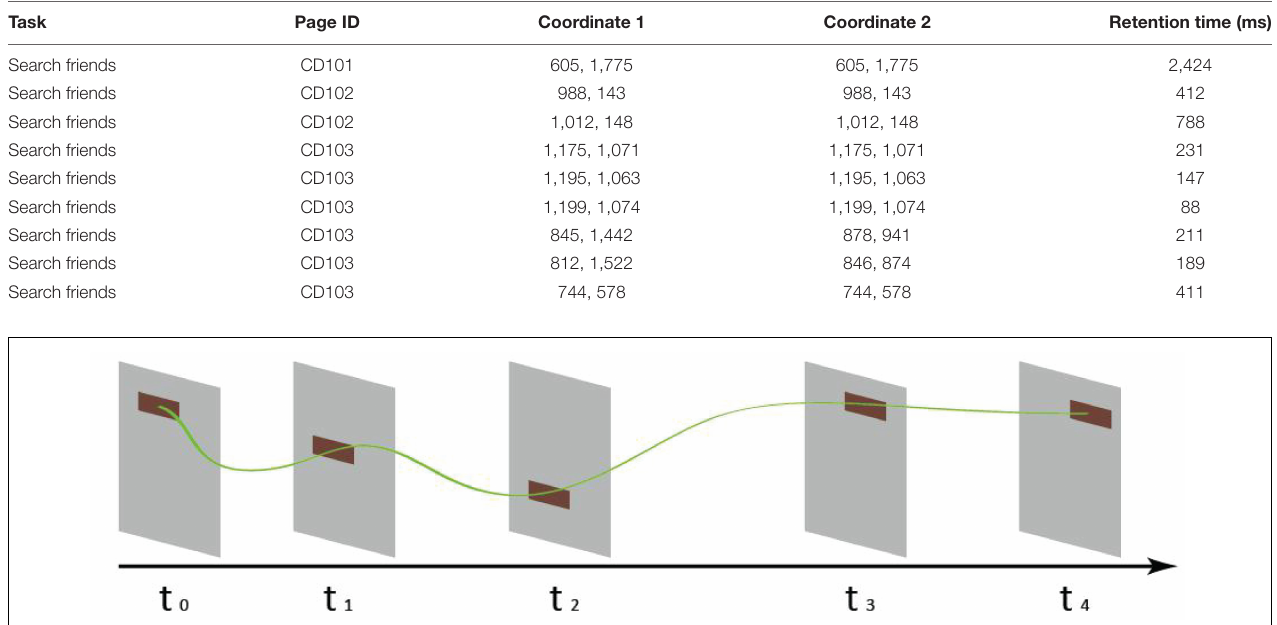
FIGURE 3 | A histogram example of Figure 2